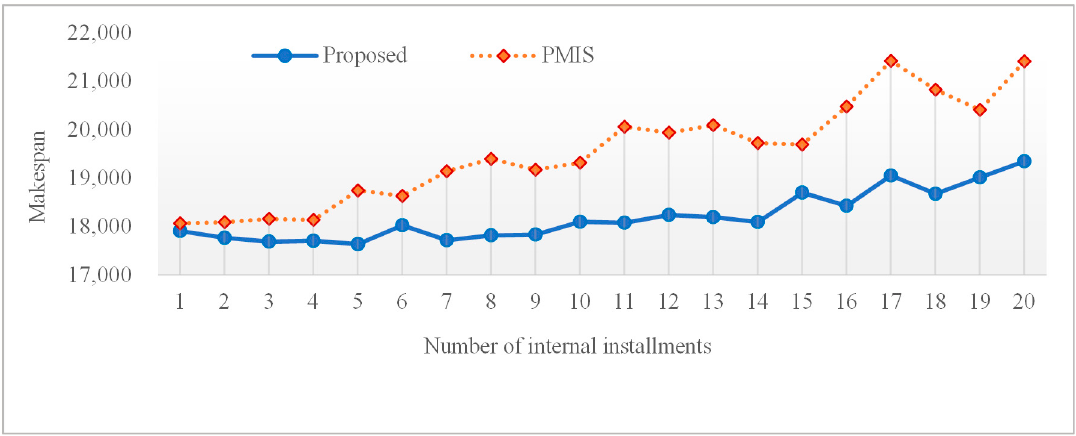
Figure 2. Makespan versus the number of installments.